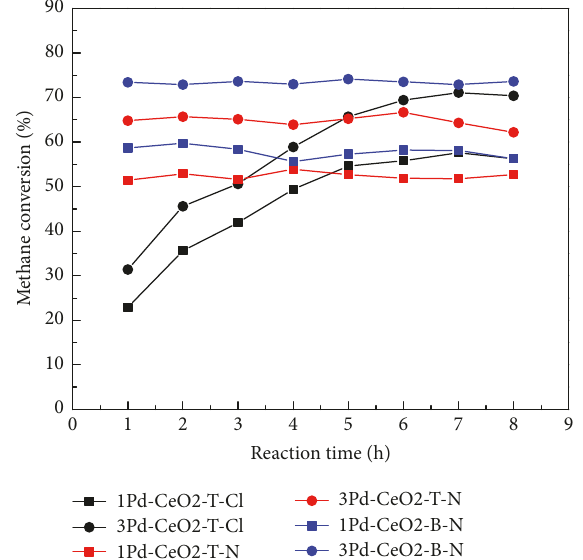
Figure 8: Catalytic activity of the obtained Pd-impregnated ceria catalysts according to percentages of methane conversion during the methane steam reforming reaction for hydrogen gas